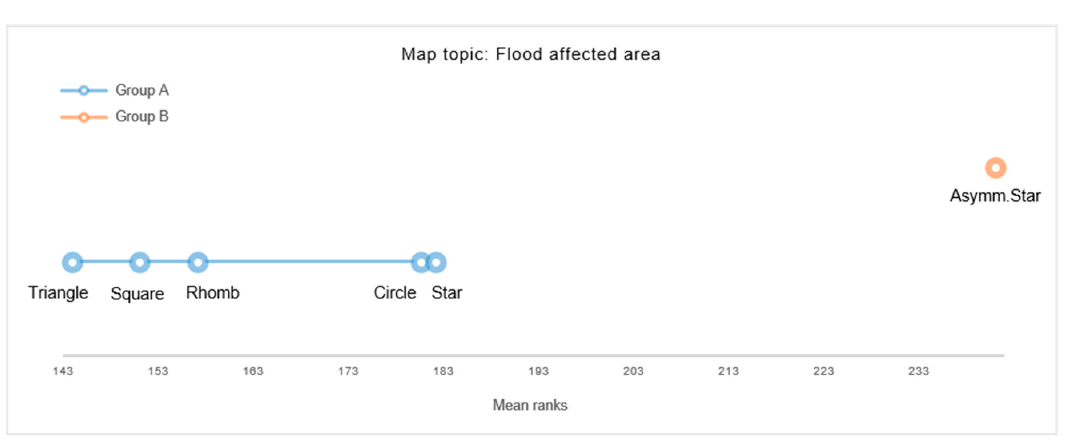
Figure 13. Map #9: Results of multiple pairwise comparisons, indicating groups of (dis)similar symbol-content congruence.